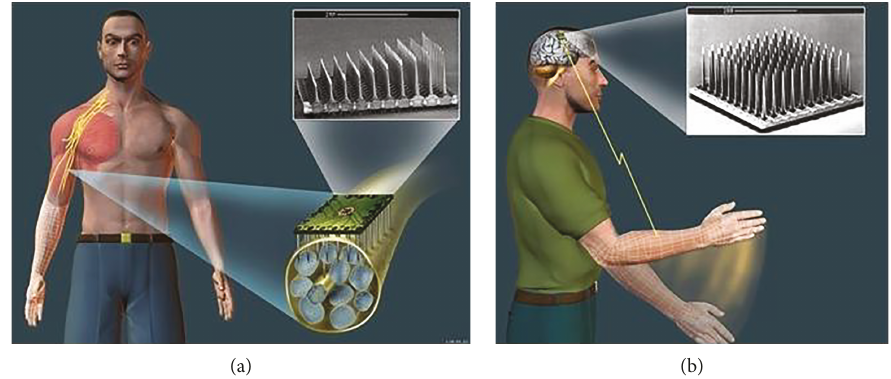
Figure 4: Penetrating microelectrode arrays to stimulate and/or record activity in individual neurons in peripheral nerves (a) [114] and cerebral cortex (b) [115]. Command signals from peripheral motor axons could be used to control prosthetic limbs, and stimulation of somatosensory a ff erents could provide perceptual feedback. Command signals from motor cortex can be used to control prosthetic limbs for amputees or neuromuscular stimulation for quadriplegic patients. Illustration provided courtesy of The Johns Hopkins University Applied Physics Laboratory.